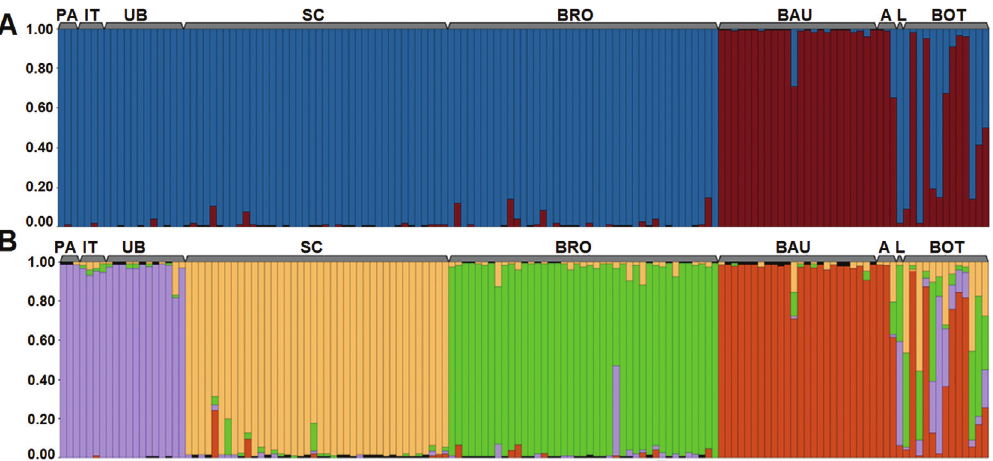
Figure 2 - Population structure. Q plots were generated by the STRUCTURE program. These are based on a multilocus analysis of the nine P. moratoi populations.Eachverticallinerepresentsanindividual,andthepercentageofthedifferentcoloredsegmentsineachlineisproportionaltotheadhesionof the individual to each of the k groups. (A) principal genetic structuring ( k = 2), (B) weaker structuring ( k = 4). PA = Paranaiguara; IT = Ituiutaba; UB = Uberlândia; SC = São Carlos; BRO = Brotas; BAU = Bauru; A = Avaré; L = Lençóis Paulista; BOT = Botucatu.